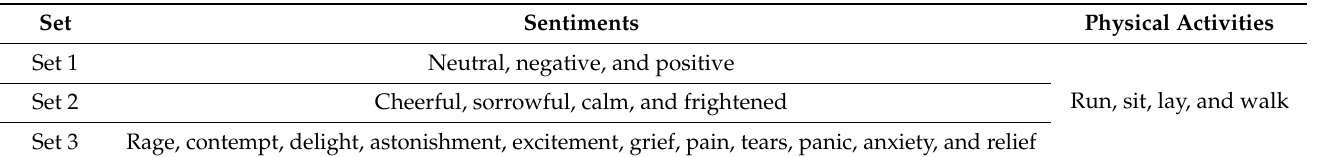
Table 2. Comprehensive spectrum of human emotions and corresponding actions utilized during the stage of